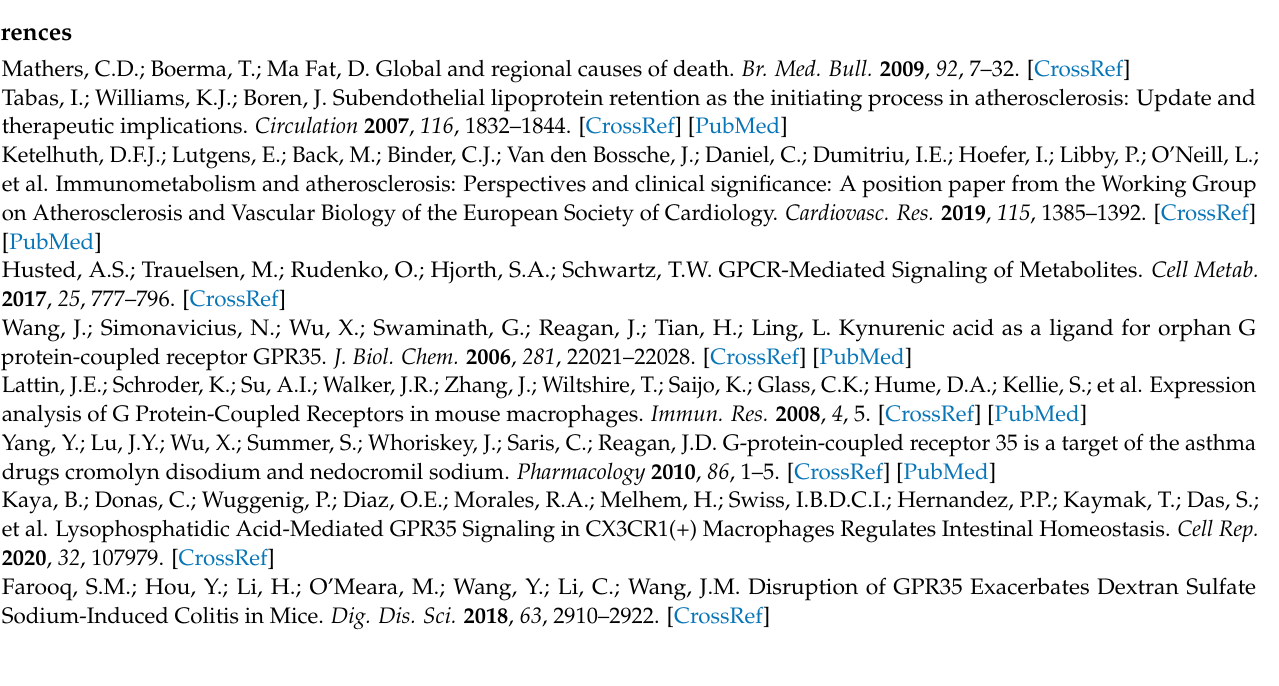
PCR setup, Table S2: qPCR primer sequences, Figure S1: Representative gels of GPR35KO and WT mice genotyping, Figure S2: Relative expression of Gpr35 in different organs of WT and KO mice, Figure S3: Dose titration of GPR35 agonists, Figure S4: The effect of GPR35 ligation with zaprinast to CXCL1 and IL-10 production on BMDMs stimulated with